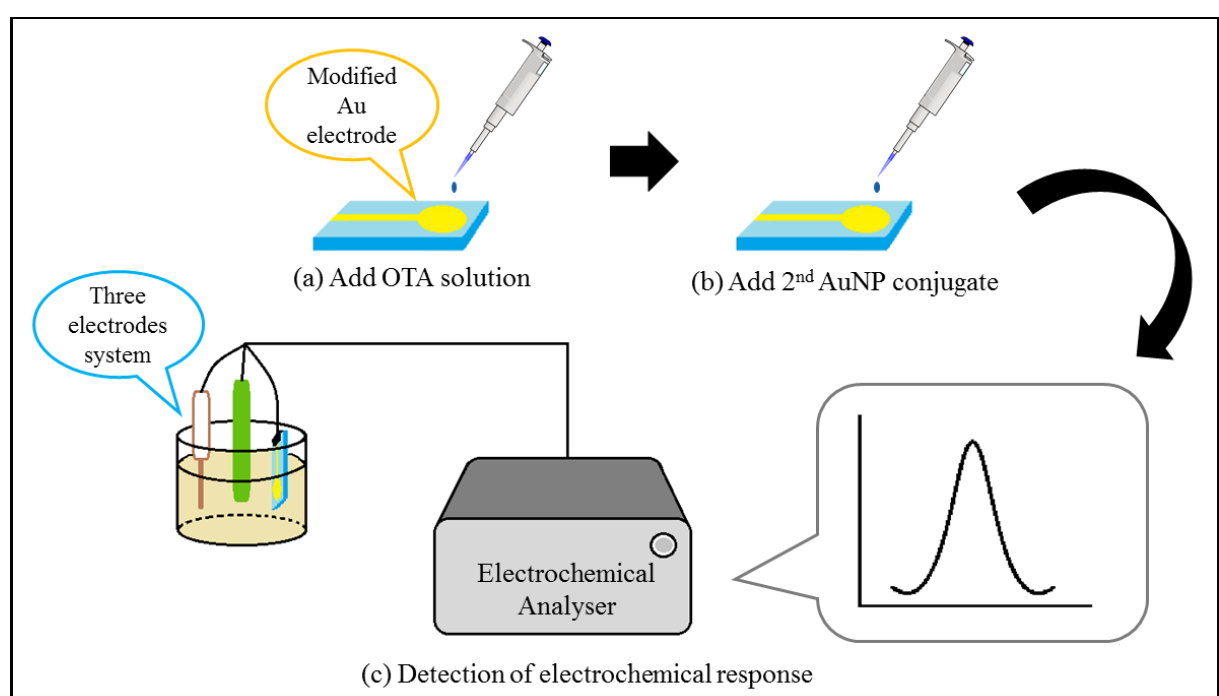
Figure 3. Schematic diagram illustrating the operation principle of indirect mycotoxin detection with a DPV aptasensor. ( a ) OTA solution was added onto the surface of modified Au electrode. ( b ) The signal amplifier, 2nd AuNP conjugate (ferrocene-tagged AuNPs) was added to compete with the OTA in the hybridisation with CP2. ( c ) The resultant electrochemical response was collected and analysed by the electrochemical analyser.